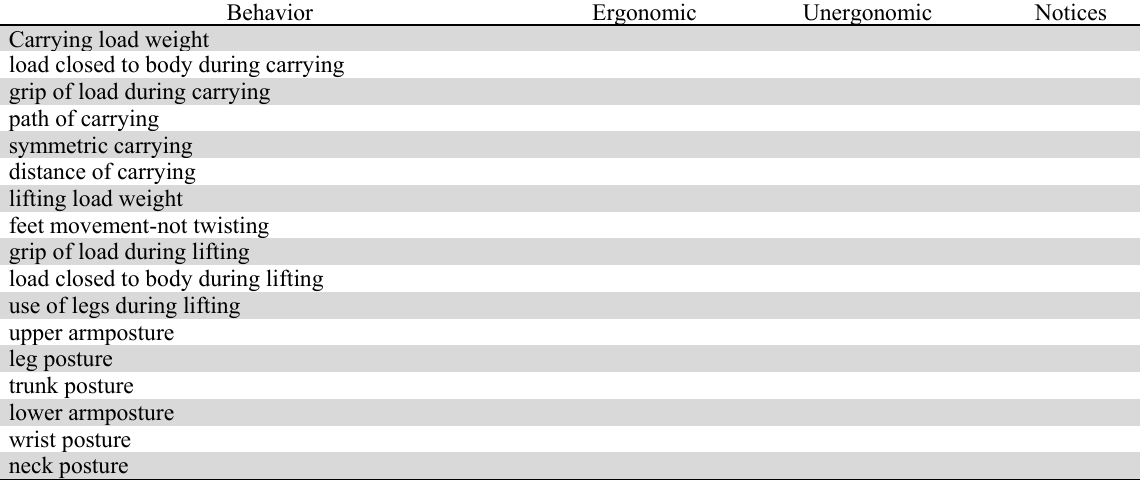
Ergonomic Behavior